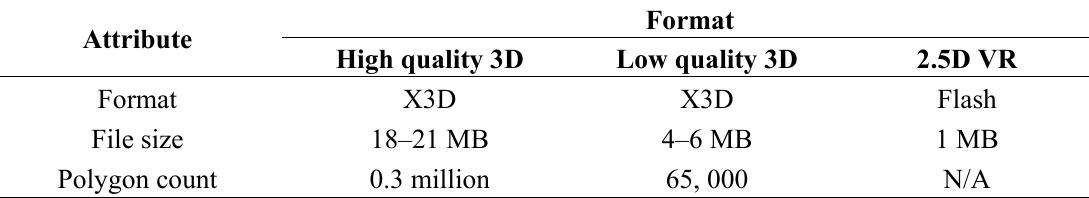
Table 2. 3D object characteristics.